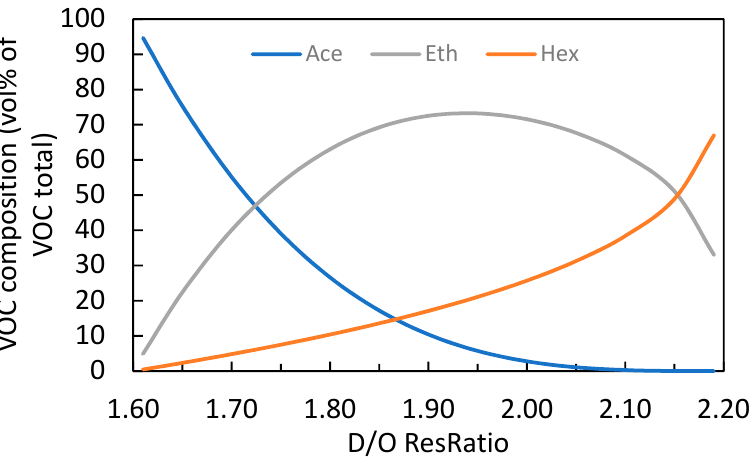
Figure 7. Empirical curves of individual VOC composition across a range of D/O resistance ratios.